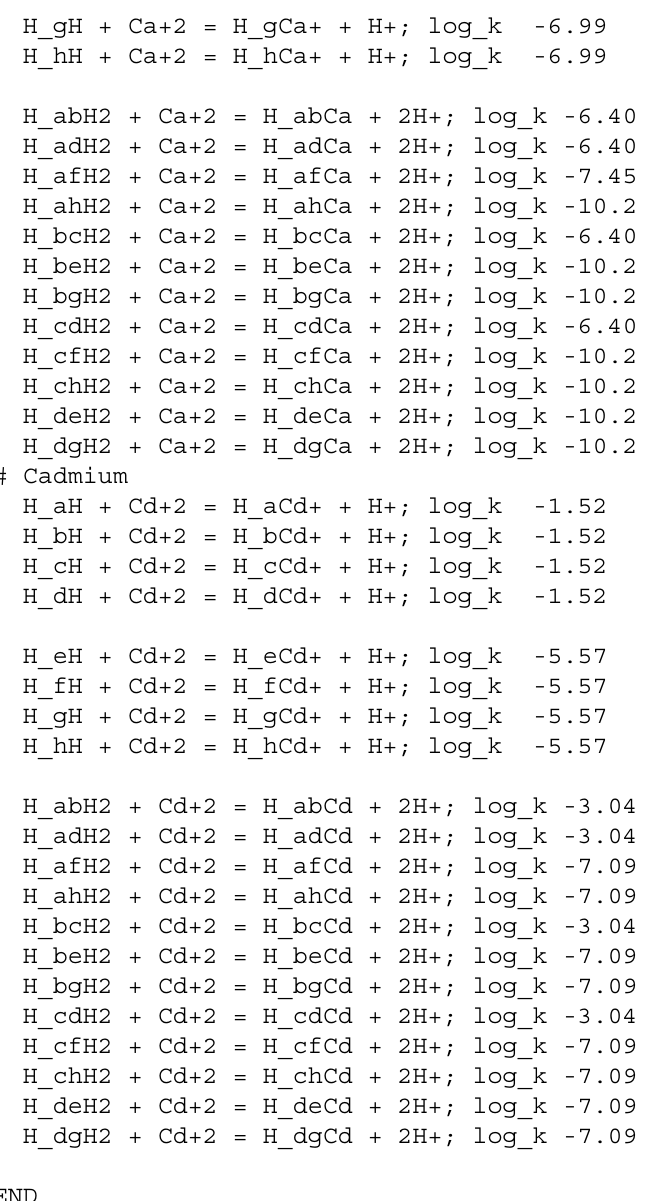
Table 56. Input file for example